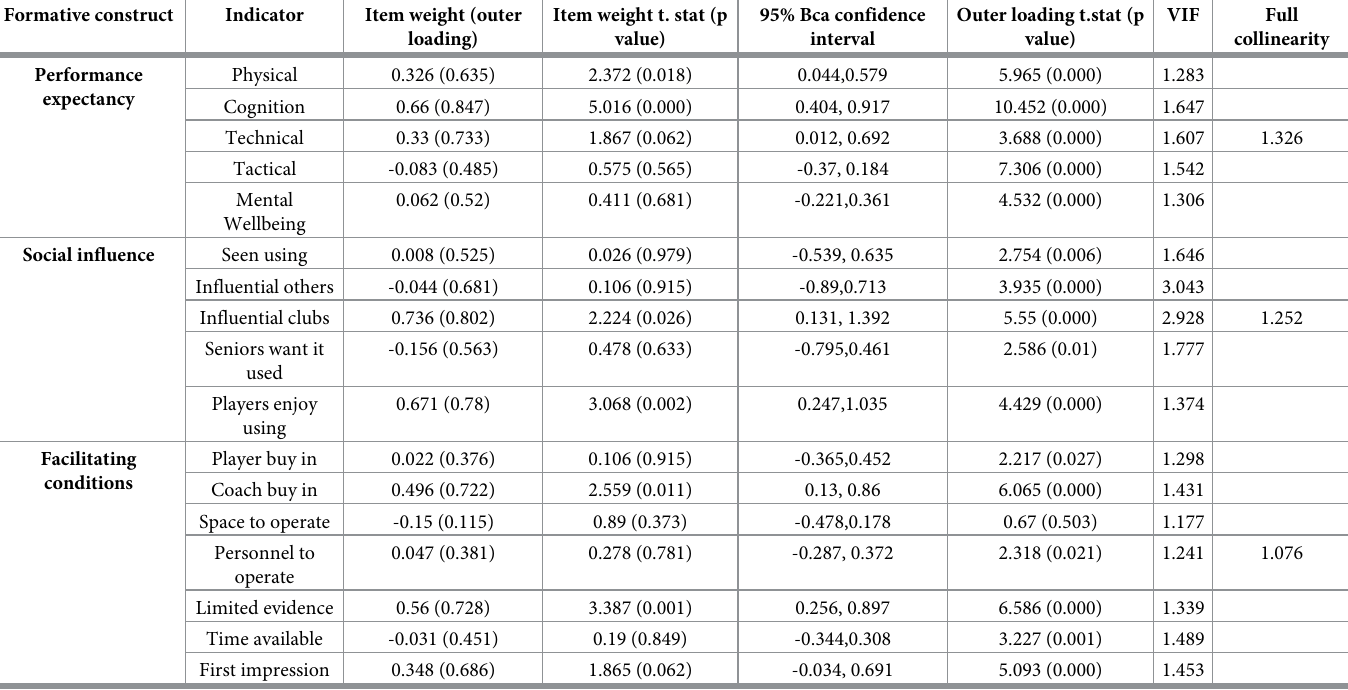
Inner model assessment. The PLS-SEM results displayed in Table 5 illustrate that the path from performance expectancy to Likeliness to use was positive ( β = .465, t = 7.028, Table 4. Formative construct indicators item weight and outer loading. Also included are the item weight and outer loading t statistic and p value, and the item weight 95% bias-corrected and accelerated confidence